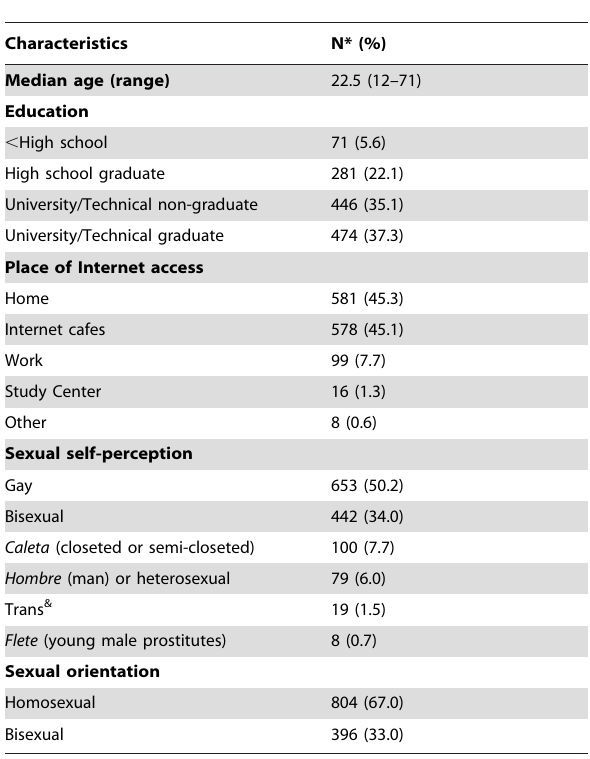
Table 1. Demographic characteristics, self-identification, and sexual orientation among MSM who answered an online survey in Peru